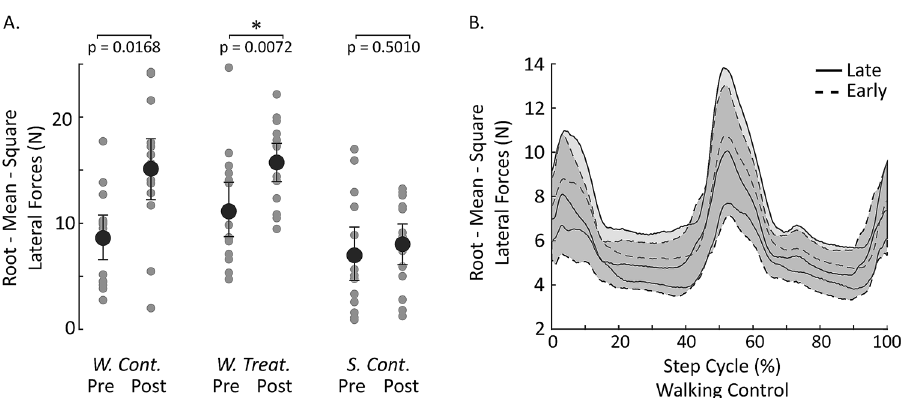
Figure 4. Medio-lateral force variability during standing and walking. ( A ) Root-mean-square (RMS) medio- lateral forces increase following walking (significantly so after the treatment condition) but not following an hour of sitting quietly (n = 15 for each group). W. Cont. walking control, W. Treat. walking treatment, S. Cont. seated control. Pre-post comparisons were performed using Bonferroni corrected t-tests, p < 0.05/3. Statistical significance indicated by *. Error bars are 95% confidence intervals for the mean. ( B ) Variability about the mean RMS medio-lateral forces during walking did not appear to change over time. Shaded area is the 95% confidence interval for the mean. The data for ( B ) were low-pass filtered at 20 Hz to remove high frequency noise from the treadmill